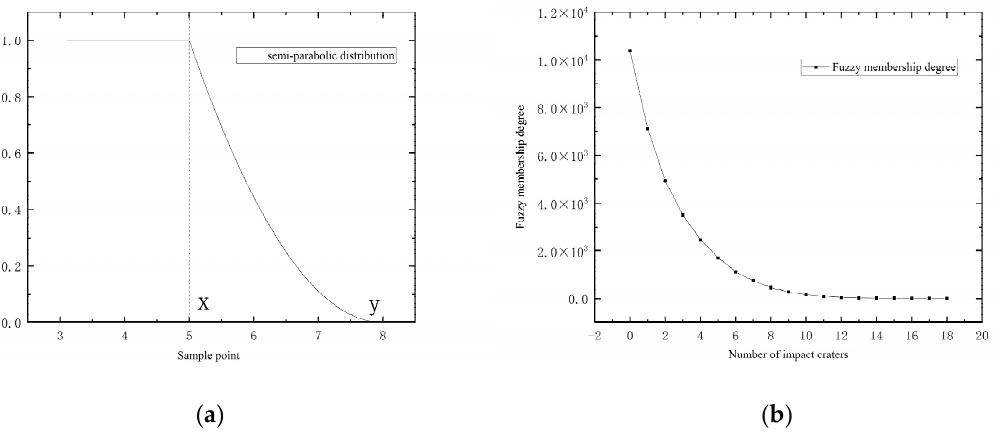
Figure 4. Semi-parabolic distribution curve in fuzzy distribution and the statistical results of the total number of cells containing more than the number of impact craters in the cells under different conditions. ( a ) Semi-parabolic distribution curve in fuzzy distribution; ( b ) the statistical results of the total number of cells containing more than the number of impact craters in the cells under different conditions.